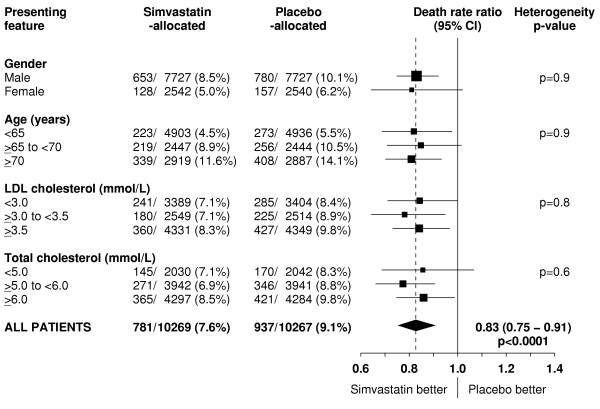
Effect of simvastatin allocation on vascular death in participants subdivided by presenting features. Symbols and conventions as in Figure 1. P-values for chi-squared tests for heterogeneity across different subgroups are given on the right.